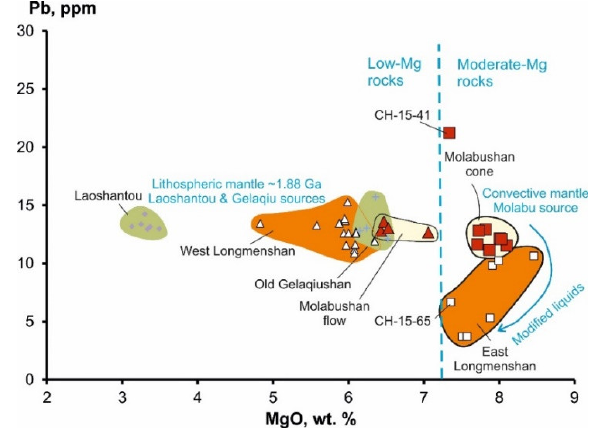
Figure 11. Pb versus MgO diagram. Symbols are as in Figure 5.